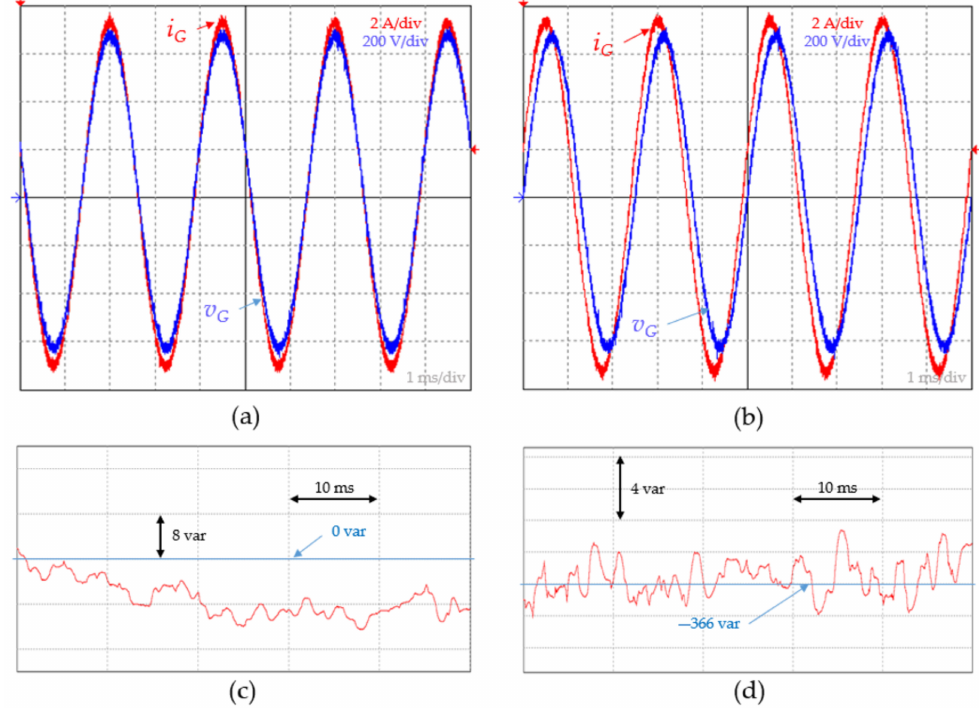
Figure 7. Steady-state waveforms of the on-board grid converter without reactive power compen- sation capability recorded for constant temperature of 298 K and solar irradiance of 1000 W/m 2 : ( a ) waveforms of the grid voltage v G and grid current i G for balanced grid; ( b ) waveforms of the grid voltage v G and grid current i G for unbalanced grid; ( c ) the reactive power for balanced grid; ( d ) the reactive power for unbalanced